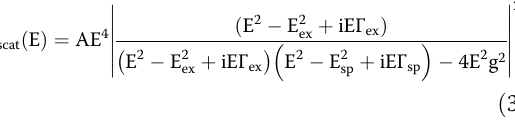
where A represents the scattering amplitude. To extract the coupling strength, we use Eq. (3) to fi t the scattering tting results also show an anticrossing behavior.